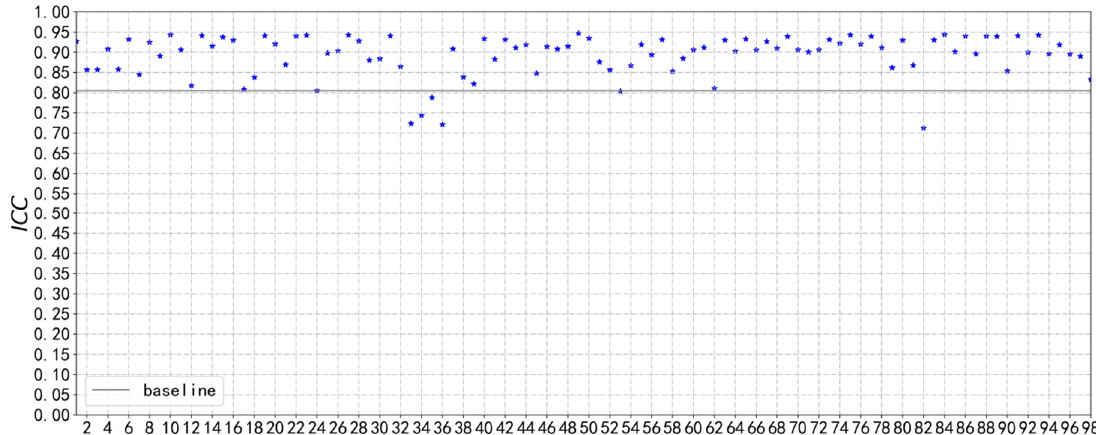
Figure 12. The ICC s of different cell voltages.